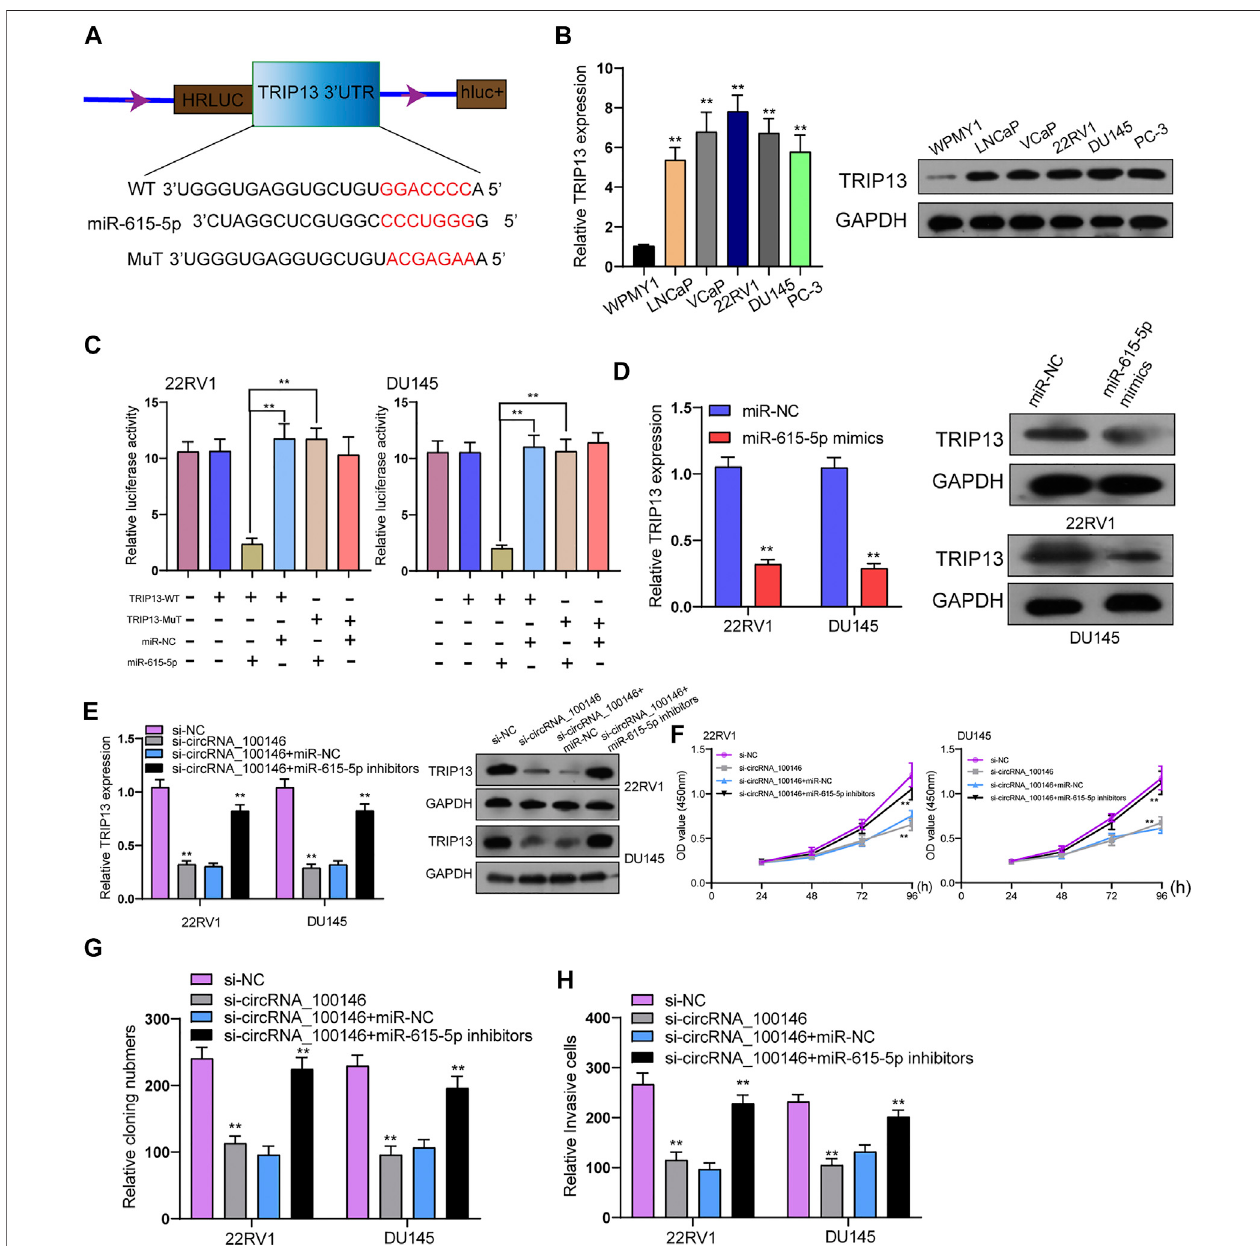
FIGURE 4 | CircRNA_100146 decreased TRIP13 expression via sponging miR-615-5p. (A) Chematic illustration of the sequence of wild type of miR-615-5p 3 ’ - UTR(WT)andmutantsequencesonthecomplementarysitesofmiR-615-5p3 ’ -UTRwithmiR-615-5p(Mutant). (B) TRIP13levelswereincreasedin fi vePCacellsbyRT- PCR and Western blot. (C) Relative luciferase activity after co-transfection of miR-615-5p mimics, miR-NC, TRIP13-Mut, and TRIP13-WT into 22RV1 and DU145 cells. (D) The transfection of miR-615-5p mimics resulted in the distinct suppression of TRIP13 expression in 22RV1 and DU145 cells. (E) RT-PCR and Western blot con fi rmed the expression of TRIP13 in 22RV1, and DU145 cells transfected with si-NC, si-circRNA_100146, si-circRNA_100146+miR-NC, or si-circRNA_100146+ miR-615-5p inhibitors. (F – H) The effects of circRNA_100146 knockdown on the proliferation and invasion were determined by CCK-8, colony formation assays, and transwell assays. ** p <